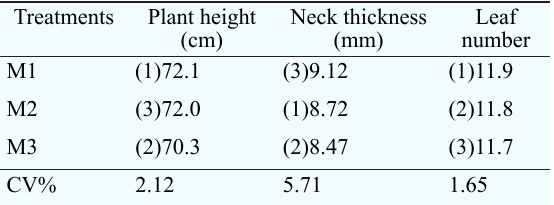
Table 1. Effect of fertilisation methods on vegetative garlic growth in cv.